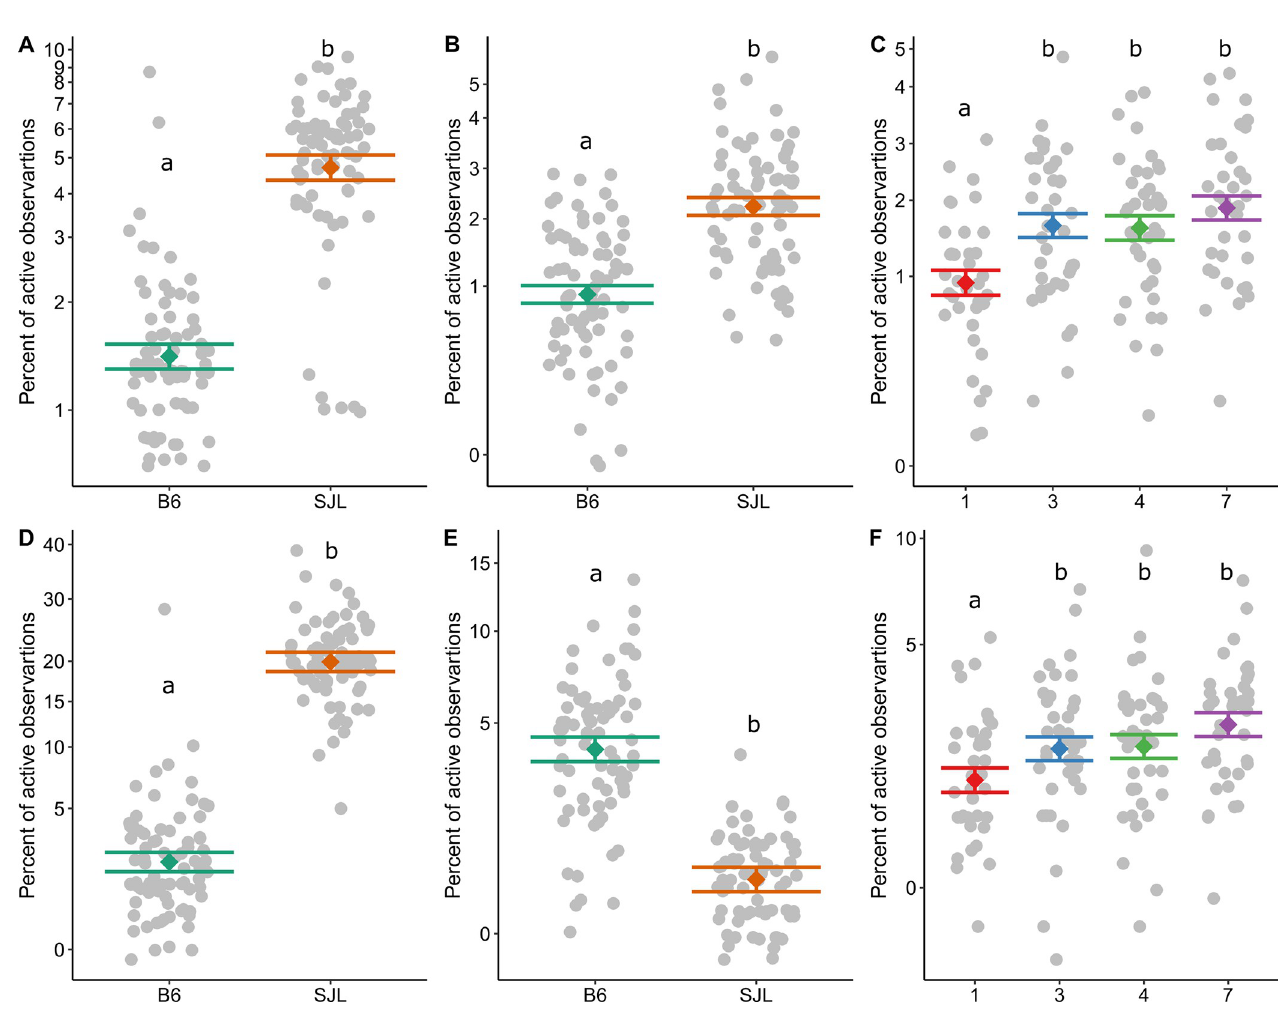
Fig 2. Social behavior was affected by strain and study day. SJL displayed more (A) escalated (P adj < 0.001) and (B) mediated aggression (P adj < 0.001). (C) Mediated aggression was also performed less on the first study day (P adj < 0.001). (D) SJL mice performed more submissive behavior (P adj < 0.001). (E) B6 mice performed more allo-grooming than SJL mice (P adj < 0.001).). (F) Allo-grooming was also performed less on the first study day (P adj < 0.001). All data are presented as factor level LSM ± SE with the scatter of individual residual error points (N = 154). Significant post hoc comparisons are indicated by differing letters within a panel. Y axes represent the percent of active time in which the behavior was observed. They are shown on a log10 back transformed scale in panel A, and a square root back transformed scale in panels B-F.